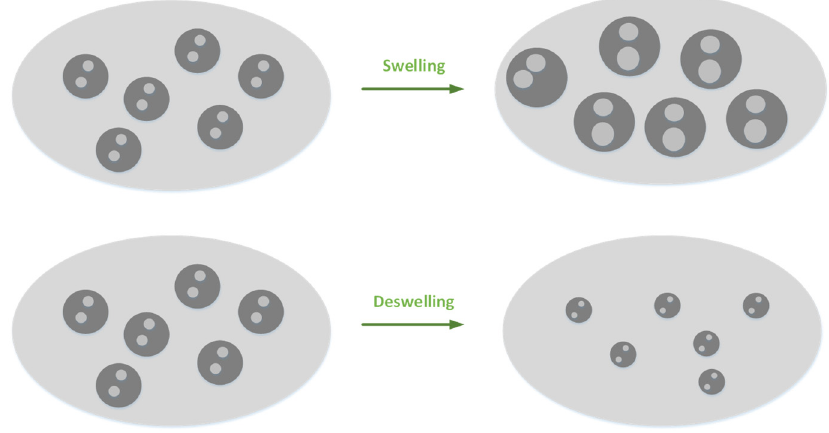
Figure 1. Schematic diagram of swelling and deswelling phenomena in double emulsions.